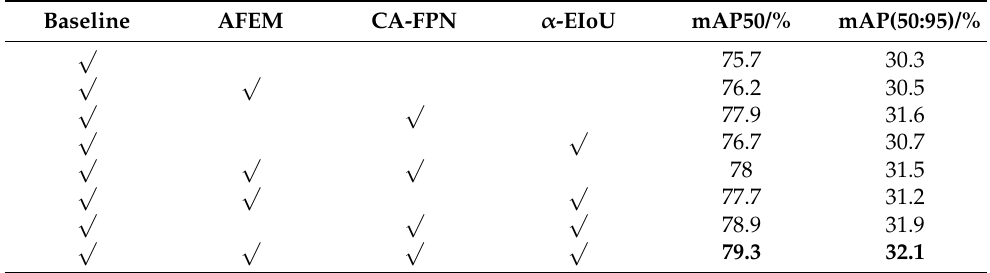
Table 1. Ablation experiment.